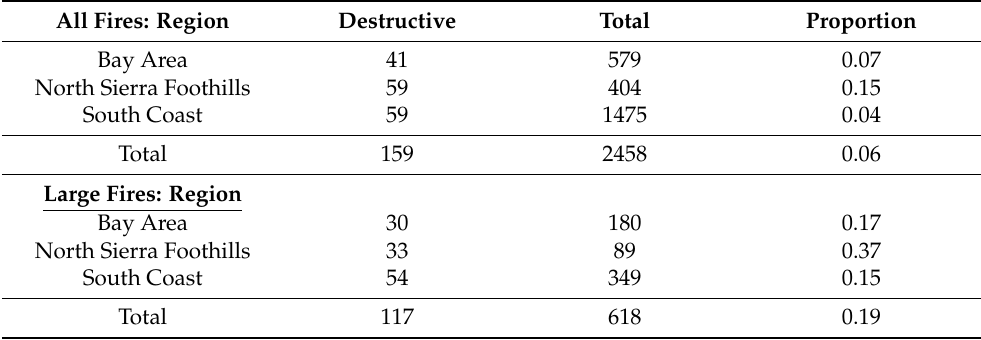
Table 1. Number of all and large ( ≥ 100 ha) destructive and non-destructive fires from 2000–2018 in three California